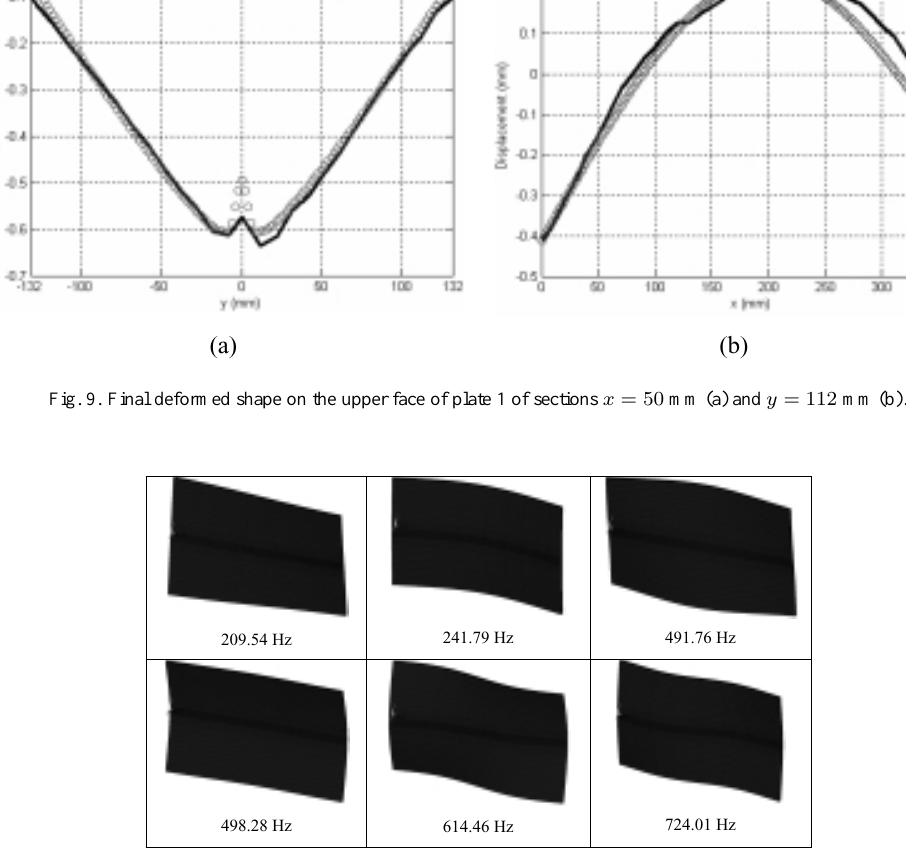
Fig. 10. The first six vibrating mode shapes of the plate without residual